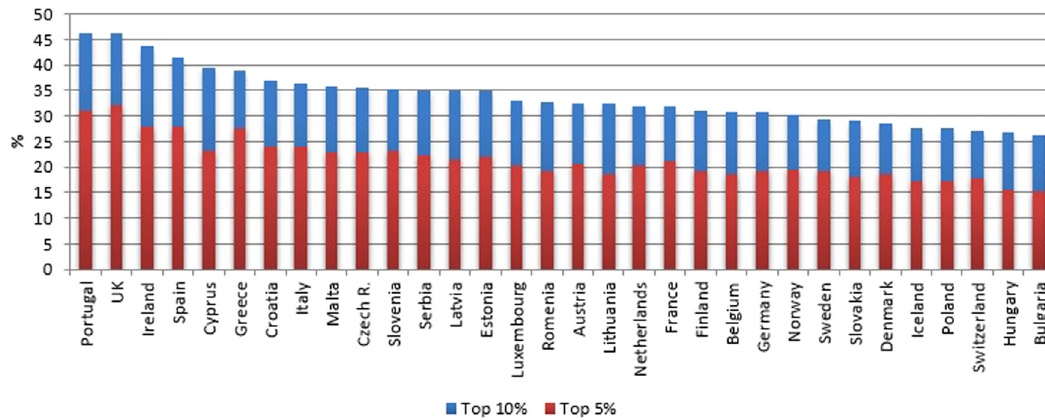
Fig. 1 Share of personal taxes paid by the top 10% and 5%, European countries (2013 – 2014) (%). Source: EU-SILC microdata 2014 and 2015.